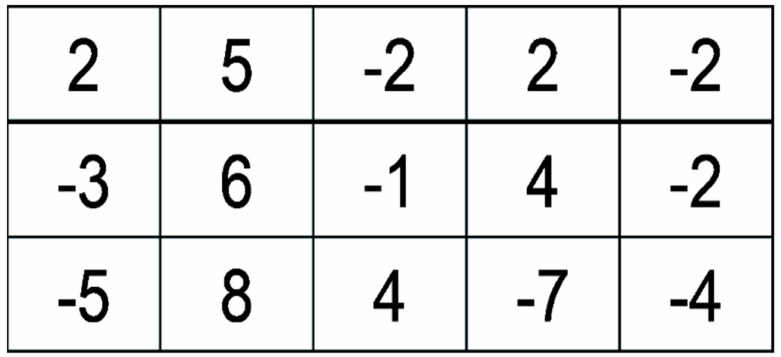
Figure 1. Block model with block economic